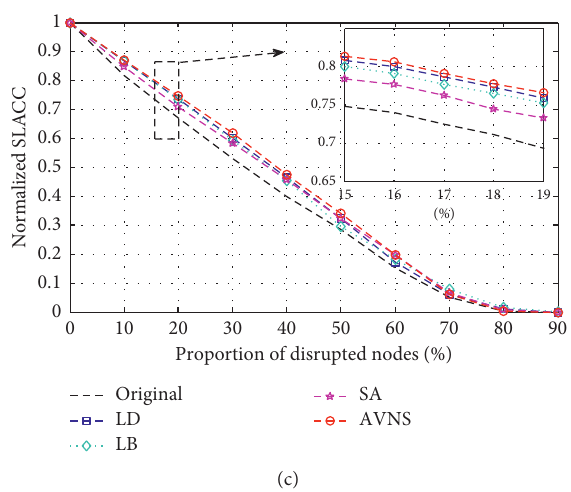
Figure 8: Response of chain 21 and reconfigured ones facing random disruptions. (a) f